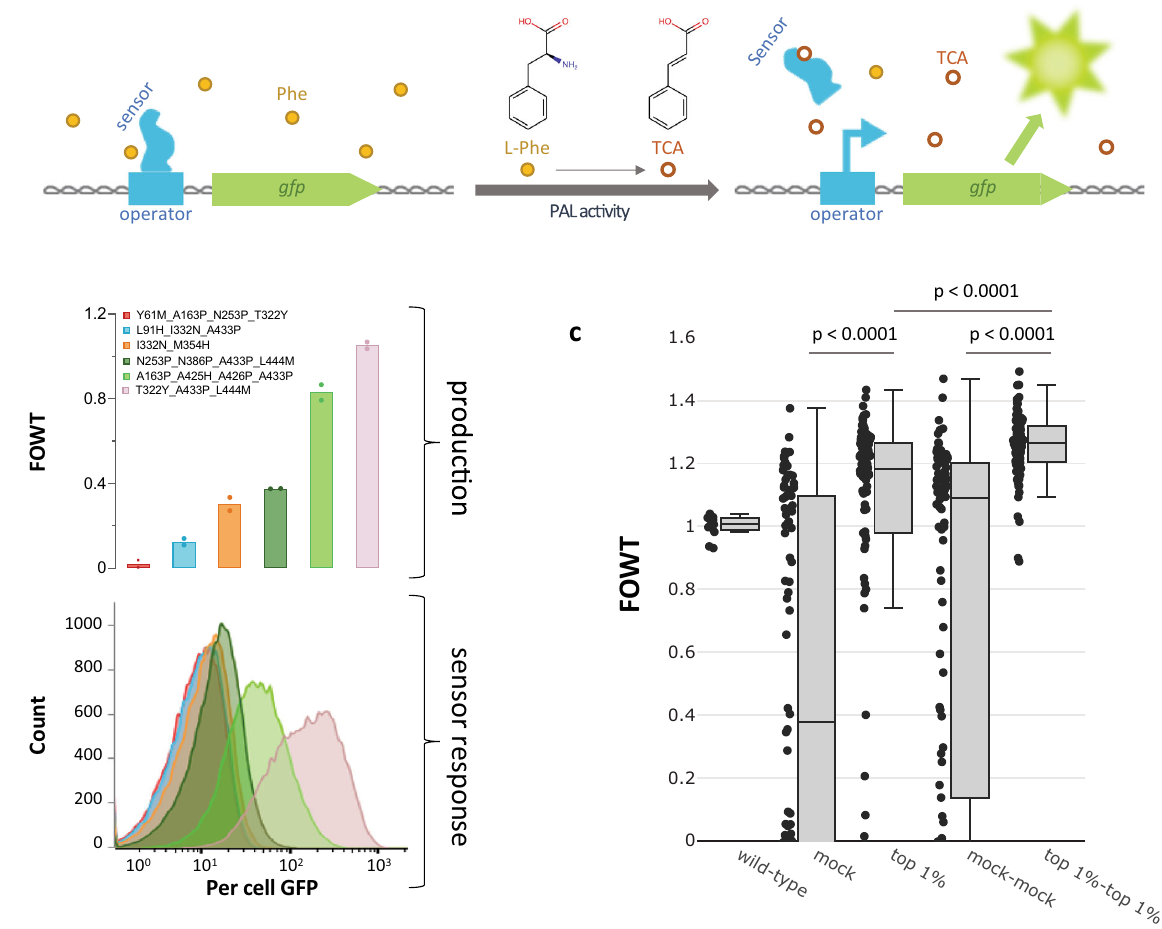
Fig. 1 TCA biosensor description and demonstration. a Schematic representation of biosensor-regulated reporter expression. In the absence of TCA, the allosteric transcription factor (aTF, labeled sensor in fi gure) binds the DNA operator site and prevents expression of the reporter gene gfp that encodes for a green fl uorescent protein (GFP). PAL activity converts L -Phe into TCA; TCA binds to the sensor aTF, causing a conformational change to relieve DNA binding (repression) and allowing the expression of the reporter gene. Symbols and abbreviations: phenylalanine ( L -Phe, yellow fi lled circles), trans - cinnamic acid (TCA, orange empty circles), PAL (phenylalanine ammonia lyase). b Top: whole-cell activity (see Methods, plate-based) of six StlA PAL variants, normalized to wild-type StlA activity (fold-over wild-type, FOWT, wild-type values can be found in the Source Data). n = 2 biological replicates, individual data points shown. Bottom: per cell GFP histograms of variants from the top panel following growth to saturation with simultaneous stlA (gene encoding for StlA) variant expression, sensor response, and gfp (gene encoding for GFP) expression. Colors are consistent between graphs. n = 1 representative culture per strain with 50,000 cells analyzed. c Enrichment demonstration of designed PAL library. Boxplots showing FOWT activity from different sort populations, with accompanying clonal data points. Boxes extend from the fi rst to the third quartile, with a centerline indicating the median. Upper and lower whiskers extend to the maximum and minimum point, respectively, within 1.5 times the interquartile range of the bounds of the box. Data points outside of the whiskers are considered outliers. Sort/control descriptions: wild-type, EcN harboring wild-type StlA, n = 12 biological replicates normalized to the average of the 12 wild-type production values; mock, library sorted based on cell size and doublet exclusion without GFP-based gating, n = 90 independent colonies from the sorted pool; top 1%, selection of top 1% brightest cells also gated based on cell size and doublet exclusion, n = 90 independent colonies from the sorted pool; mock-mock, mock population retransformed into fresh EcN background with sensor and mock-sorted a second time without GFP selection, n = 90 independent colonies from the sorted pool; top 1%-top 1%, top 1% population retransformed into fresh EcN background with sensor and sorted for its top 1% brightest cells, n = 90 independent colonies from the sorted pool. P values were calculated using Welch ’ s ANOVA test with Dunnett ’ s T3 multiple comparisons is described in more detail below, was achieved using a micro fl uidic-based work fl ow (Fig. 1c; mock vs top 1% p < 0.0001, mock-mock vs top 1%-top 1% p < 0.0001, and additional enrichment from top 1% to top 1%-top 1% p < 0.0001, Welch ’ s analysis of variance (ANOVA) test with Dunnett ’ s T3 multiple comparisons test).